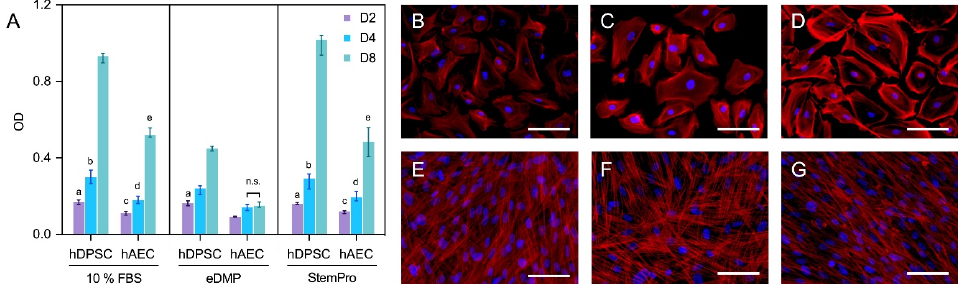
Figure 2. Viability and morphology of hAECs and hDPSCs. Cell viability of hAECs and hDPSCs cultured with eDMP and StemPro after 2, 4 and 8 days ( A ). Median values and 25–75% percentiles were calculated from three independent experiments performed in triplicate ( n = 9). Fluorescence microscopy of hAECs and hDPSCs cultured with different media after 7 days and stained with DAPI and phalloidin ( B – G ). Cells were cultured in DMEM with 10% FBS ( B , E ), with eDMP ( C , F ) and with StemPro ( D , G ). hAECs exhibit a cobblestone-like morphology ( B – D ) while hDPSCs exhibit a mesenchymal stem cell phenotype ( E – G ). (Scale bars: 50 µm.)